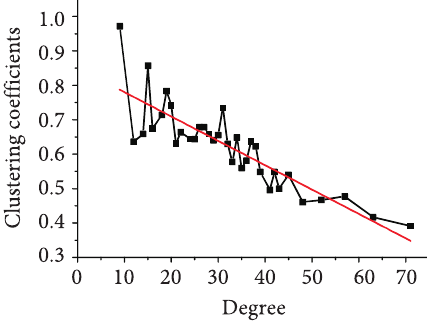
Fig. 4. Relationship between clustering coefficient and degree in network S